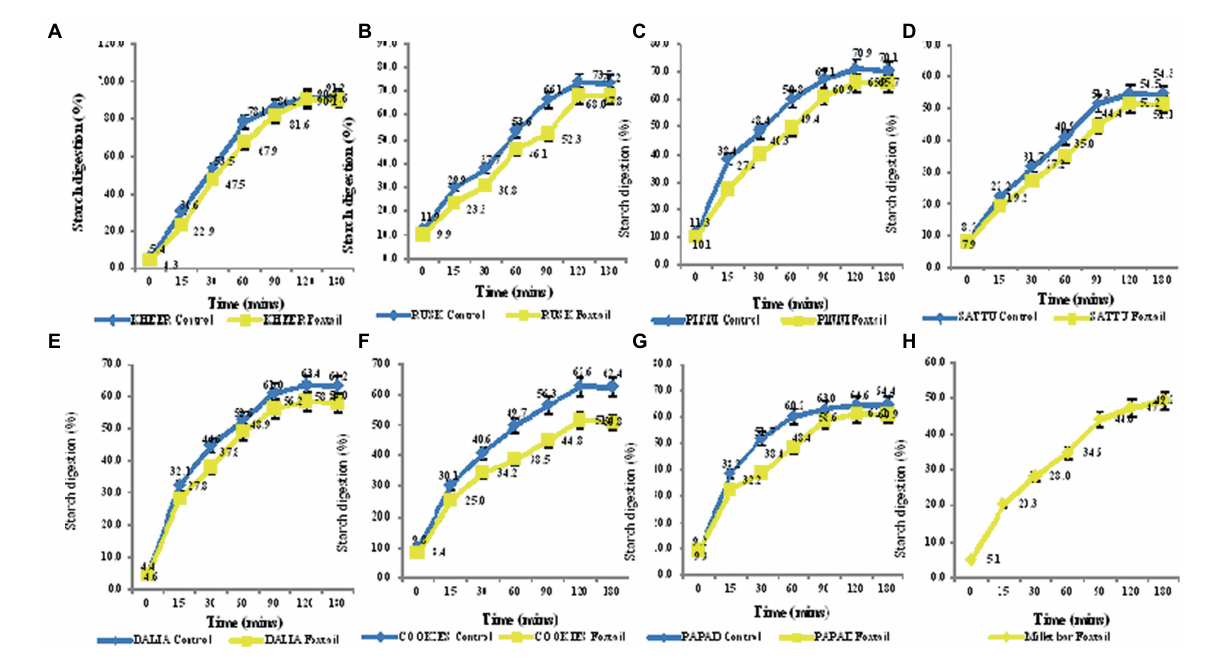
FIGURE 5 (A–H) In vitro starch digestion rate of value added products prepared from Foxtail millet and the control group.